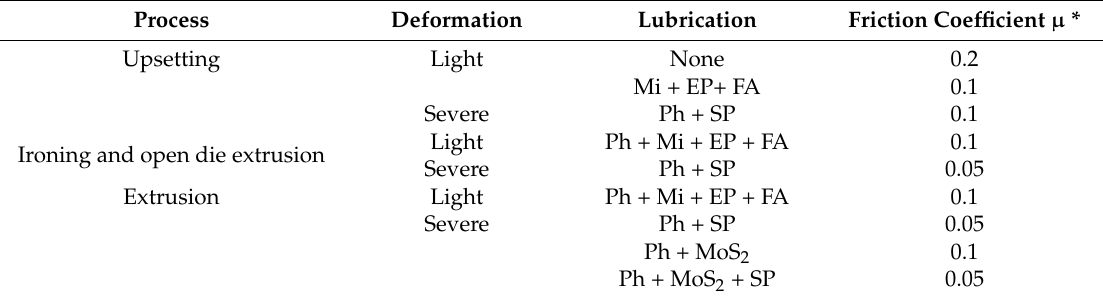
Table 6. Recommended lubricant in cold forging of steel and approximate values of the friction coefficient [45].